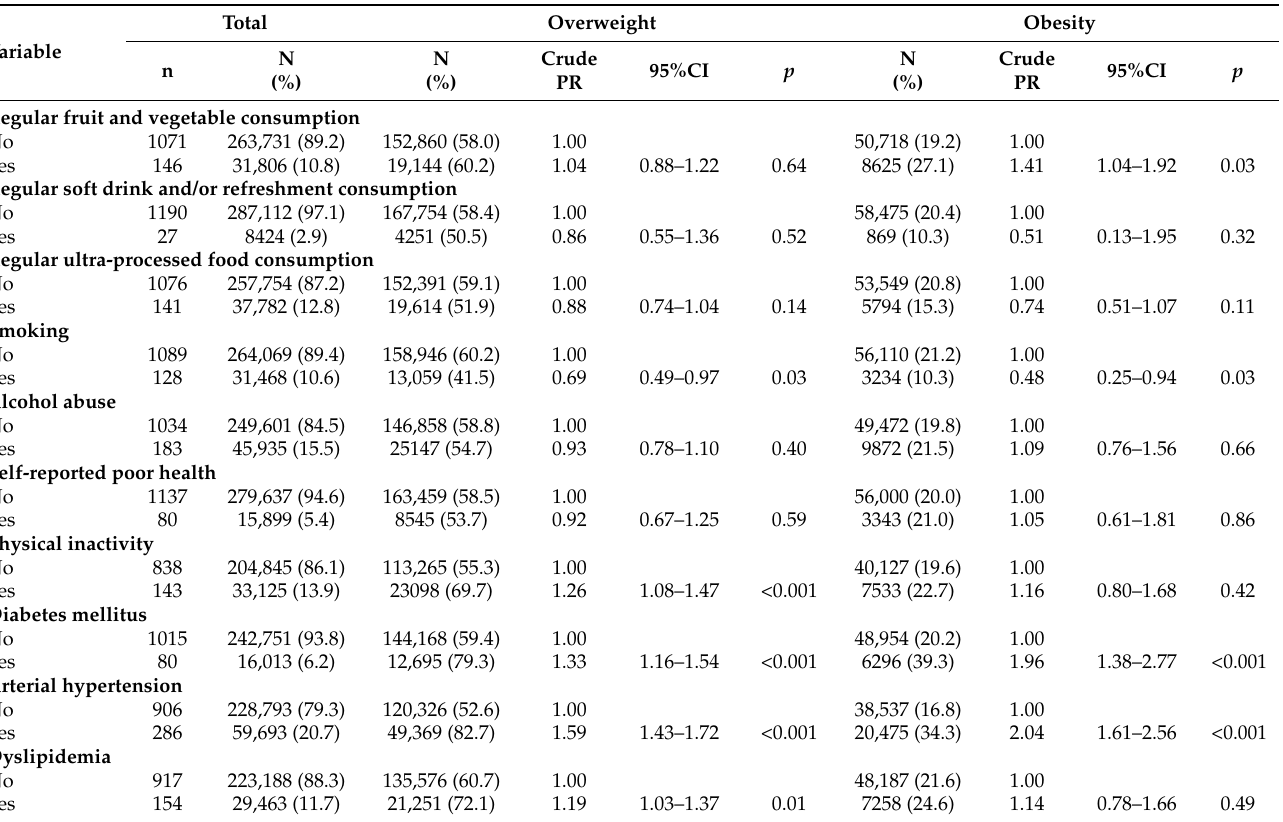
Table 2. Prevalence of overweight and obesity according to lifestyles and health of adults in Rio Branco, Acre,